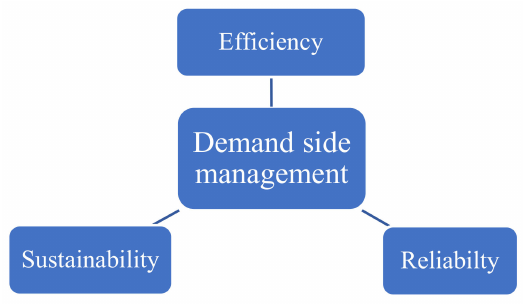
Figure 5. Functions of DSM in